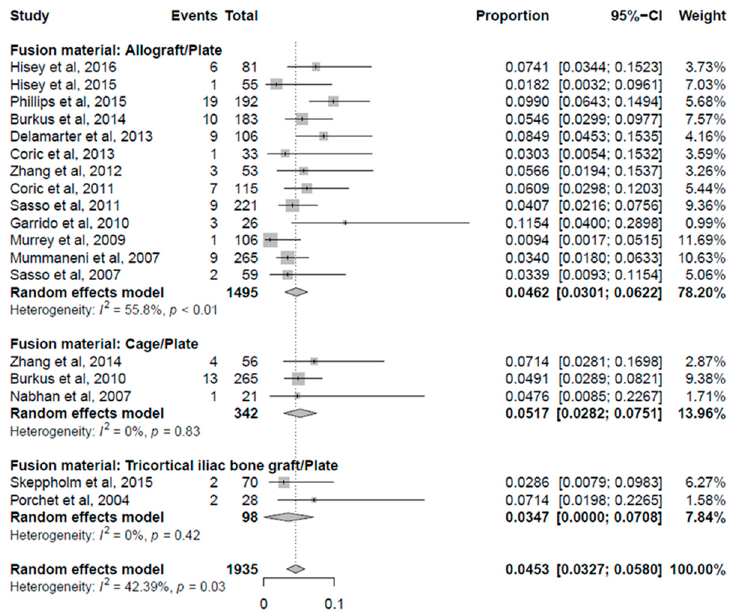
Figure 4. Forest plot comparing cASP that underwent surgery by fusion material.